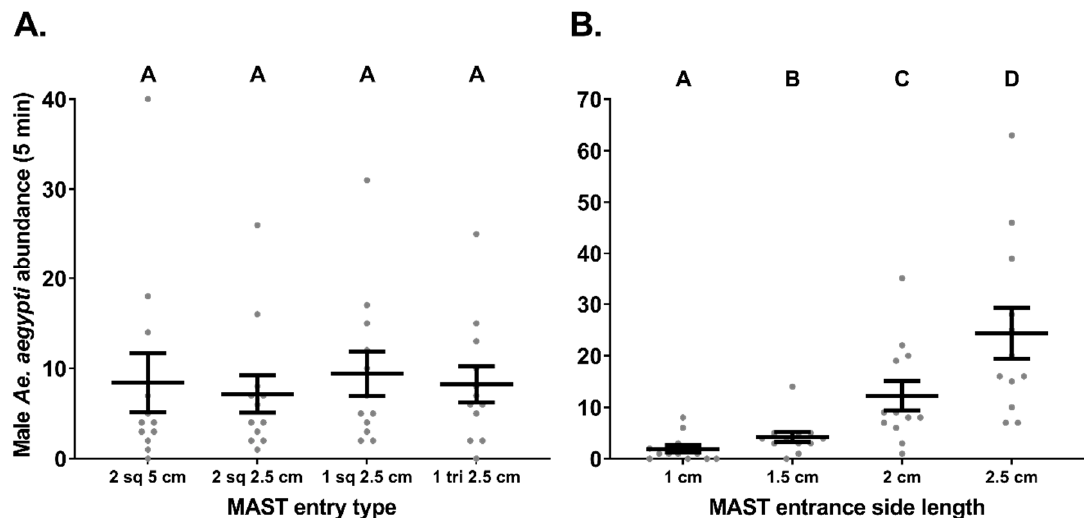
Figure 3. The influence of different entrance types on male Ae. aegypti (mean ± S.E.) catch rates in the MAST. Trials investigated catches of male Ae. aegypti (per 5 min) in semi-field trials investigating influences from different entrance ( A ) types and ( B ) sizes. Square entrances are referred to by “sq” and the triangular entrance is referred to by “tri”. The length of the sides of the entrance type is also noted in treatment labels. Different letters indicate significantly different groups (Tukey HSD, p ≤ 0.05, n = 12).